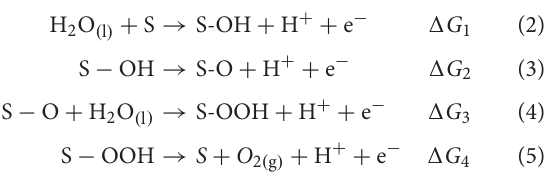
( Figure 2 , black lines), which corresponds to the usual conditions of DFT calculations within the CHE framework.